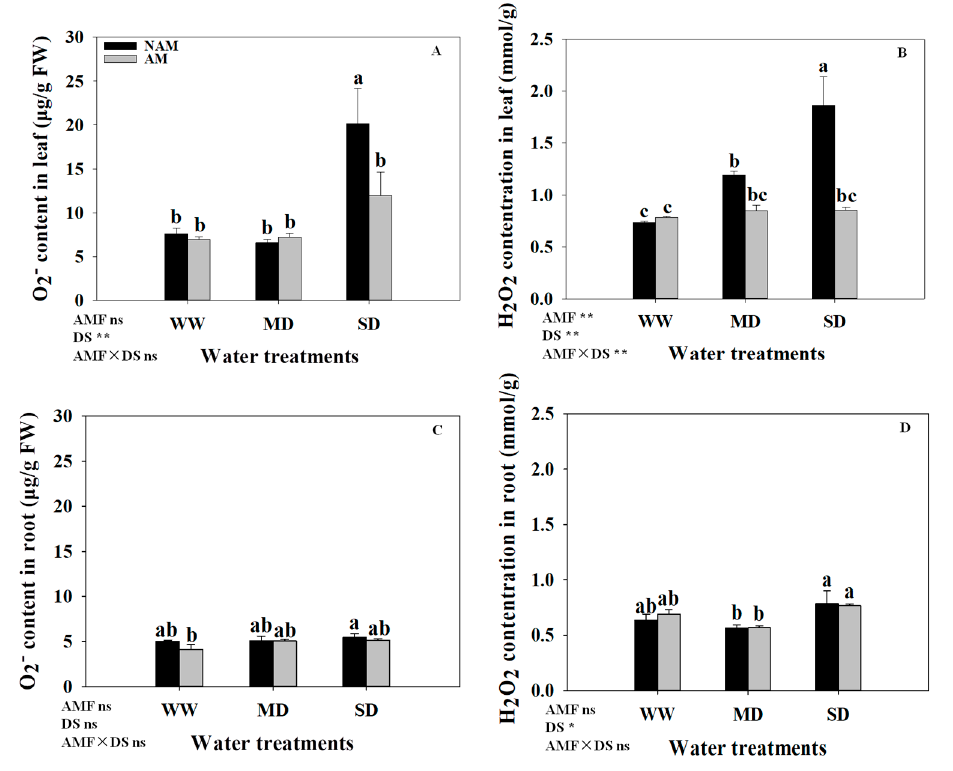
Figure 5. Effect of the arbuscular mycorrhizal fungus (AMF) Rhizophagus intraradices on the O 2- and H 2 O 2 contents in ( A , B ) leaves and ( C , D ) roots of Catalpa bungei seedlings under DS.